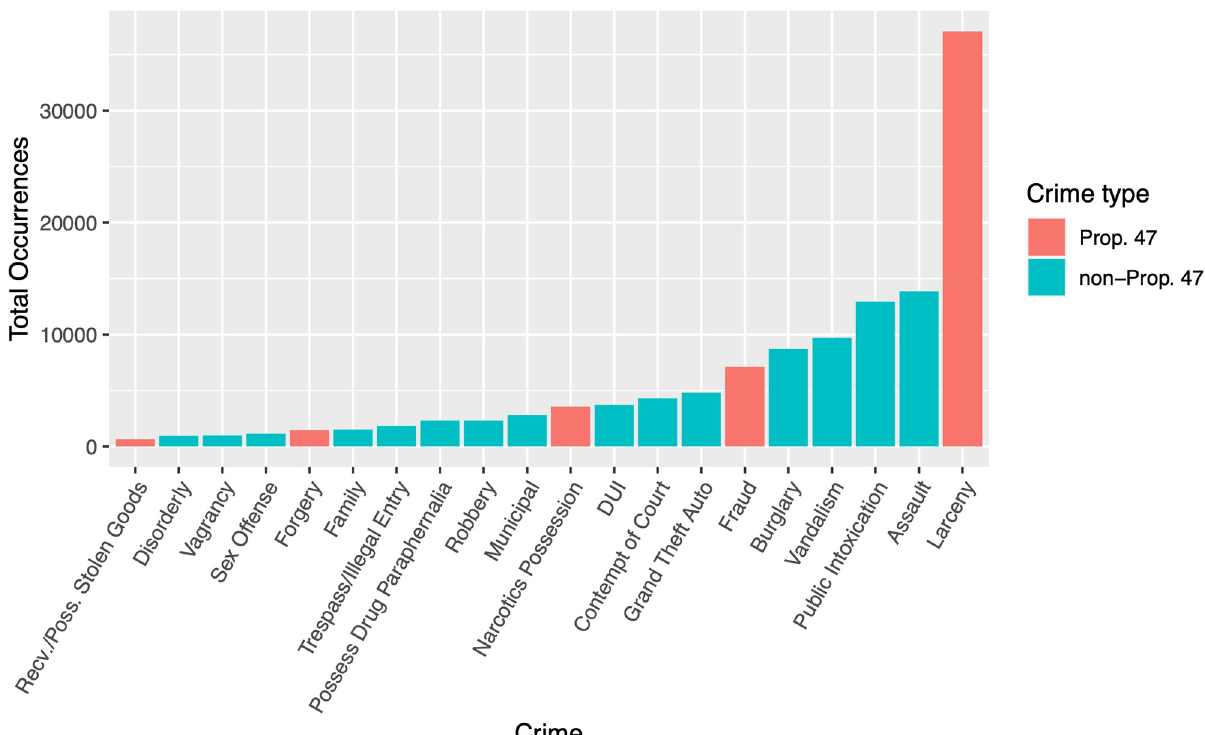
Fig 1. Reported crimes in Santa Monica, CA, 2006–2019, by crime type. Reclassified crimes are as follows: receiving/possessing stolen goods, forgery, narcotics possession, fraud, and larceny. All others do not fall under the provisions of Prop. 47. Data is from Table